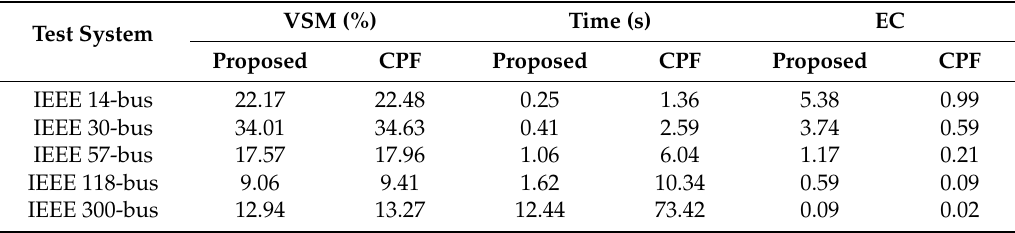
Table 3. Comparison of the results for the considered test systems in load change